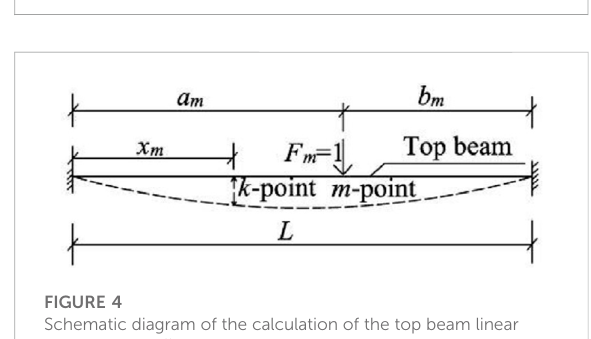
FIGURE 3 Calculation model of the top beam.